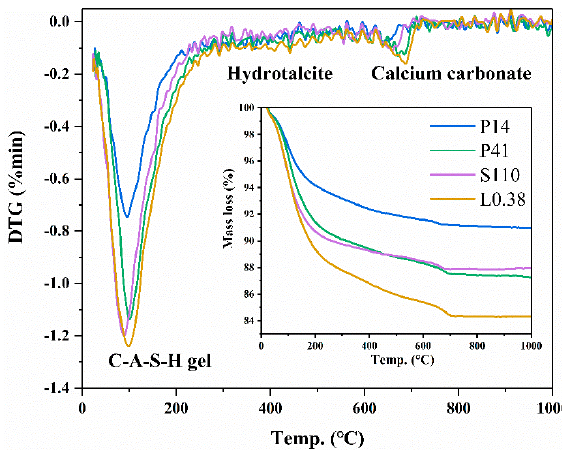
Figure 9. TG analysis of group P14, P41, S110 and L0.38.